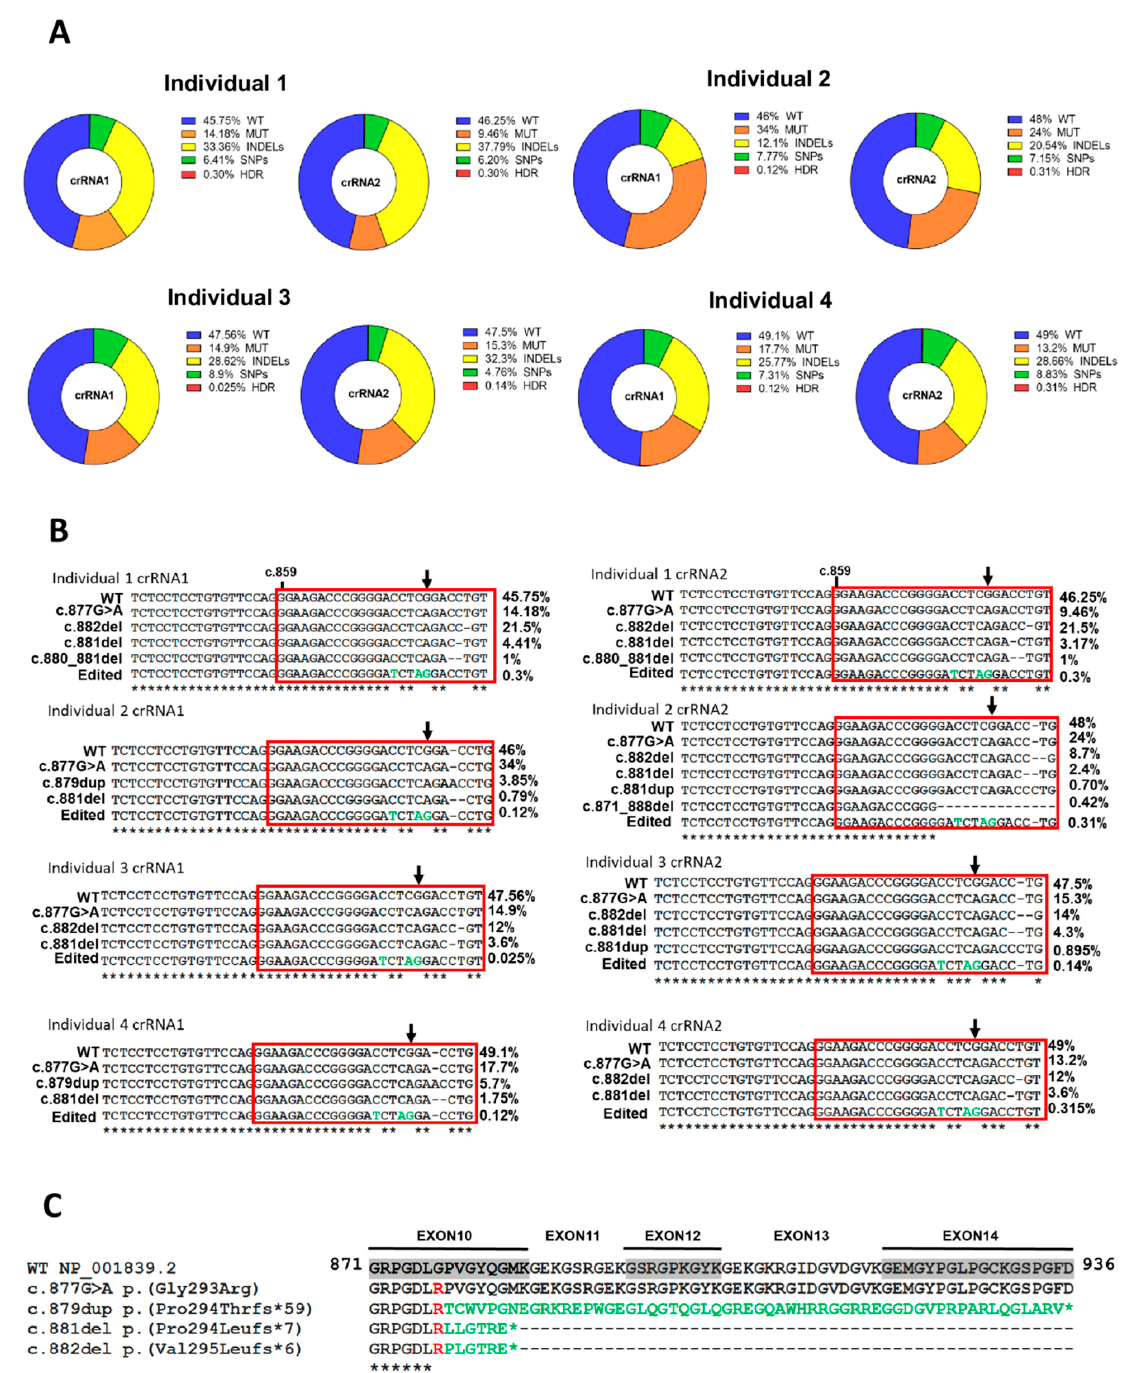
Figure 2. Analysis of the allelic variability in edited patient-derived fibroblasts. ( A ) Wild-type (WT), mutant (MUT), insertions and deletions (INDELs), single nucleotide polymorphisms (SNPs) and homology-directed repair (HDR) allele percentages after analysis of edited fibroblasts of the four individuals by next-generation sequencing. ( B ) Alignment of the most frequent allelic variants at the cDNA level in each of the fibroblasts of the individuals edited with crRNA1 or crRNA2. The changes introduced in the ssDNA template are represented in green in the variant allele resulting from the HDR. ( C ) Alignment at the protein level of the WT sequence encoded by exons 10 to 14 of the mutant variants associated with the most frequent alleles. Arginine present in the pathogenic allele is shown in red and aberrant tails up to the premature stop codon (*) in